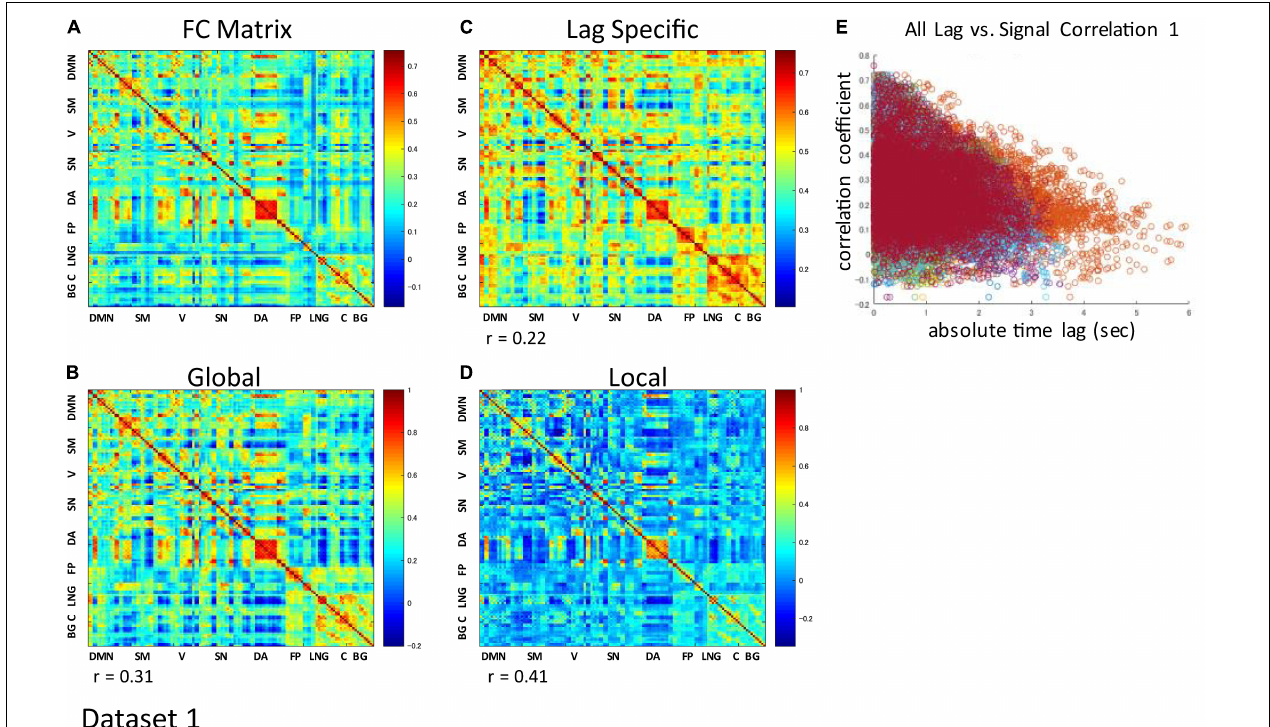
FIGURE 3 | Contribution of each component to RSN synchronization. Whole signal Functional Connectivity (FC) matrix had significant positive correlation with the global component correlation matrix ( A vs. B ), suggesting the contribution of the global component to the RSN synchronization. Significant correlation is also shown even when the global component was reconstructed without considering the spatial difference of its magnitude ( A vs. C ). Correlation matrix of the local component is also fairly similar to the FC matrix, suggesting an equivalent contribution of locally limited activity to RSN synchronization ( A vs. D ). For each global component, there was significant negative correlation between the strength of synchronization (FC) and the relative time lag between each ROI, which confirmed the contribution of the time lag of the global component to RSN synchronization (E)